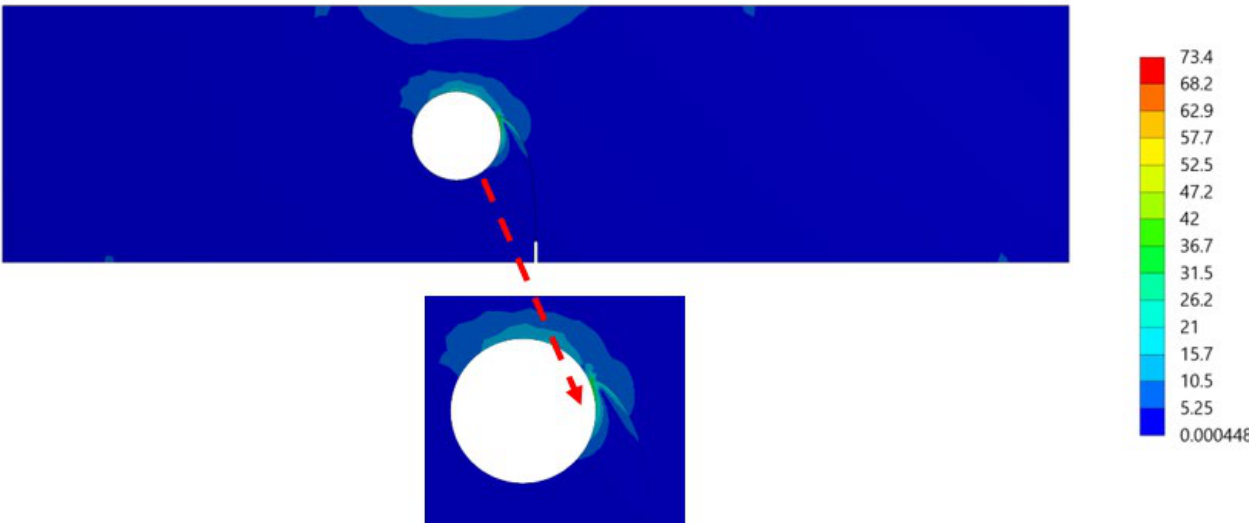
Figure 16. The distribution of a von Mises stress (MPa) at the last step of the crack’s propagation.